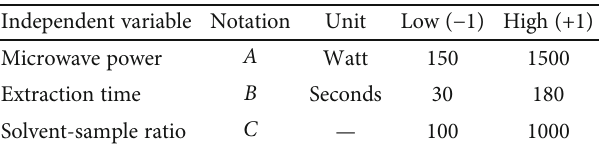
Table 1: Independent variables and their levels used in two-level FFD.